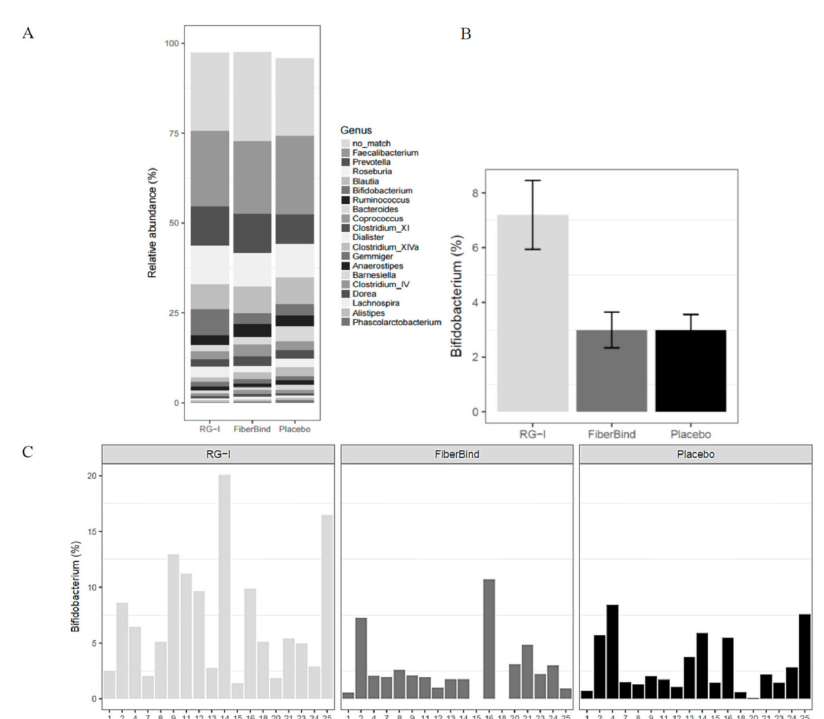
Figure 5. ( A ) Taxa summary plot at the genus level. Values illustrate mean values across the samples sorted according to the highest mean abundance. Only the 20 most abundant families and genera are shown. ( B ) Relative abundance (mean ± SEM) of the genera Bifidobacterium after three weeks of intervention with the three test buns (RG-I: n = 18, FiberBind: n = 16, control: n = 17). ( C ) Relative abundance of the genera Bifidobacterium per subject. Abbreviations: RG-I, rhamnogalacturonan